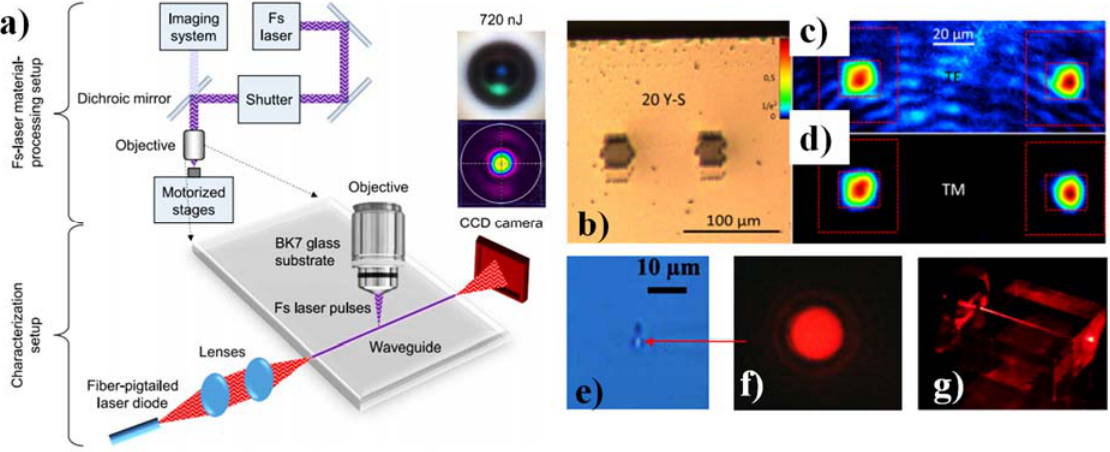
Figure 7. ( a ) Schematic of the fs-laser material processing system and the characterization method [149], ( b ) Microscope image of the Y-splitter laser written in KTP crystal [19], ( c ) Near field pattern of the Y-splitter for TE-polarized light [19], ( d ) Near field pattern of the Y-splitter for TM-polarized light [19], ( e ) Microscope view of the fs-written borosilicate glass WG [160], ( f ) Near field profile of 650 nm red laser light of the same WG [160], ( g ) Camera view of the red laser beam coupling of fs written WG [160].